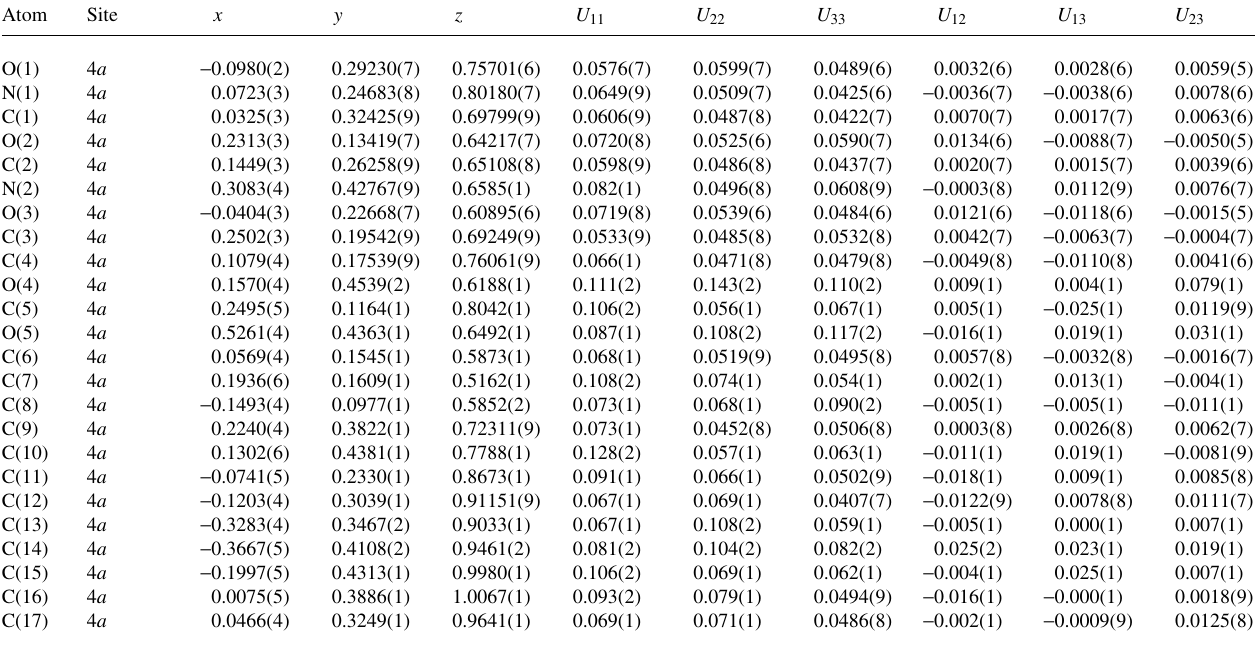
Table 3. Atomic coordinates and displacement parameters (in Å 2 ) .